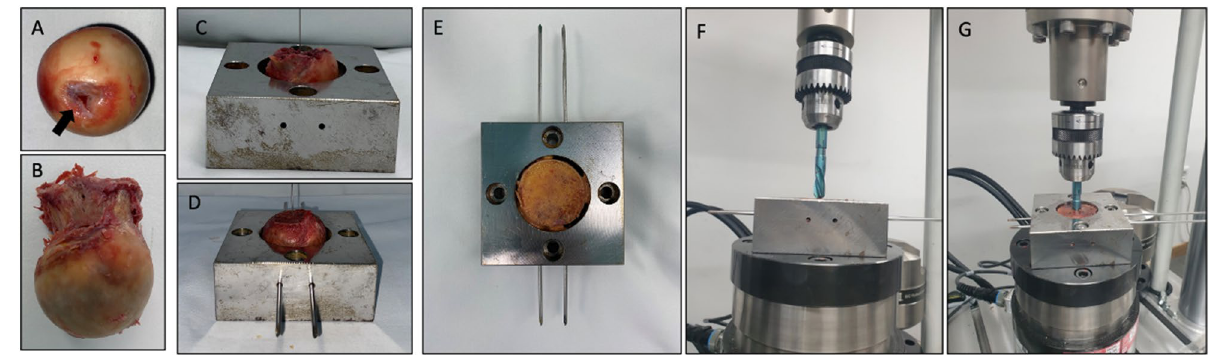
Figure 3. Retrieved femoral head ( A , B ) is placed in the jig ( C ) and stabilized with multiple k-wires ( D ). The protruding part of the femoral head is resected ( E ) leaving femoral head with 20 mm height for the mechanical test. After fixating jig to the universal test machine, the lag screw is adjusted so that the tip is in contact with the resected surface of femoral head ( F ). The lag screw is advanced for 25 mm ( G ) which results in 5 mm cut through on the femoral head. Arrow indicates fovea